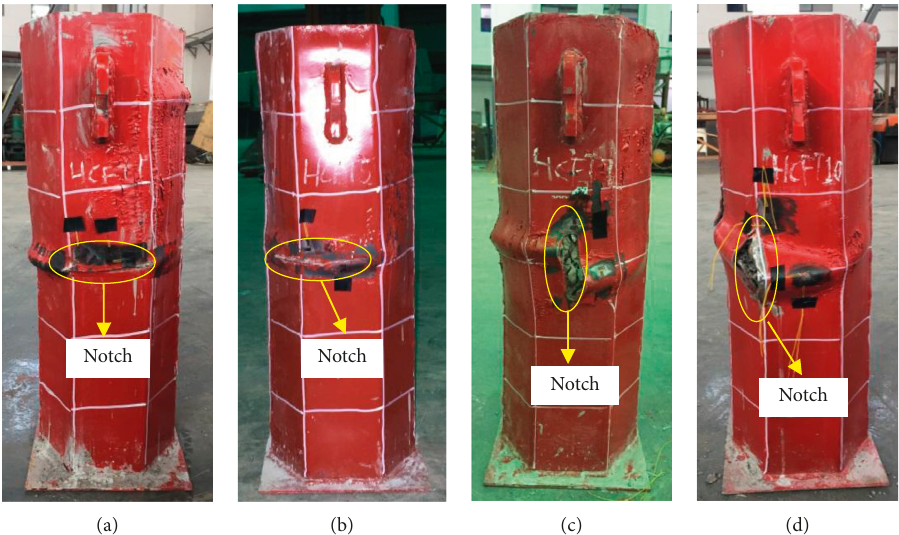
Figure 4: Failure modes for hexagonal CFSTcolumns. (a) Horizontal notch in the sideway. (b) Notch in the corner. (c) Vertical notch in the sideway. (d) Vertical notch in the